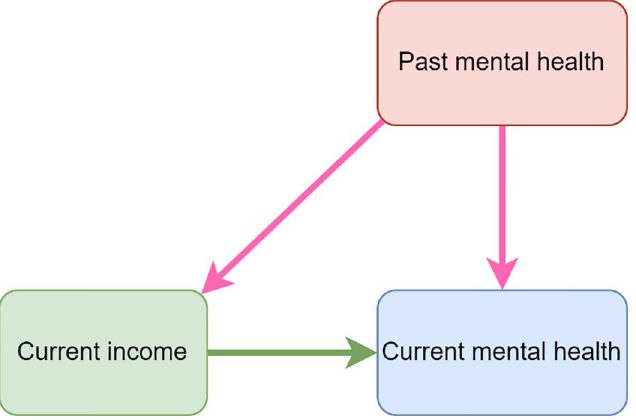
Fig 2. DAG diagram of the relationship between current income, past mental health and current